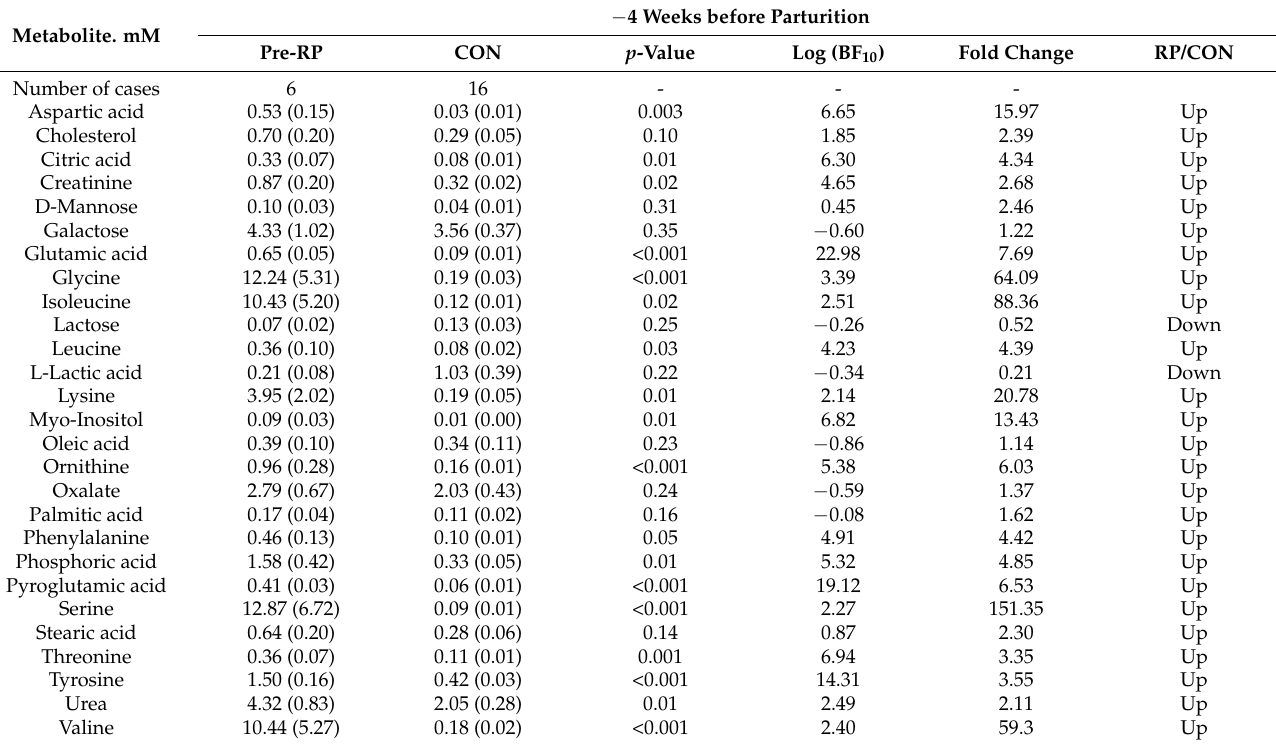
Table 2. Concentrations of altered serum metabolites [mean(SD)] in healthy controls (CON) and pre-retained placenta (Pre-RP) cows at − 4 weeks pre-partum as determined by GC/MS. Metabolite.